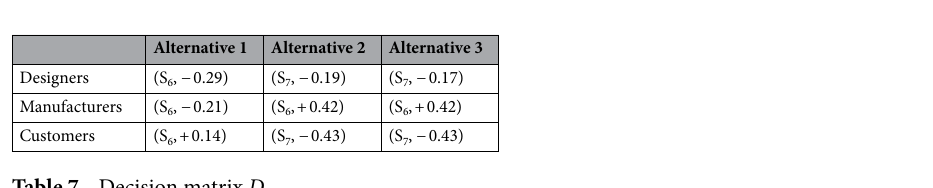
Table 7. Decision matrix D.